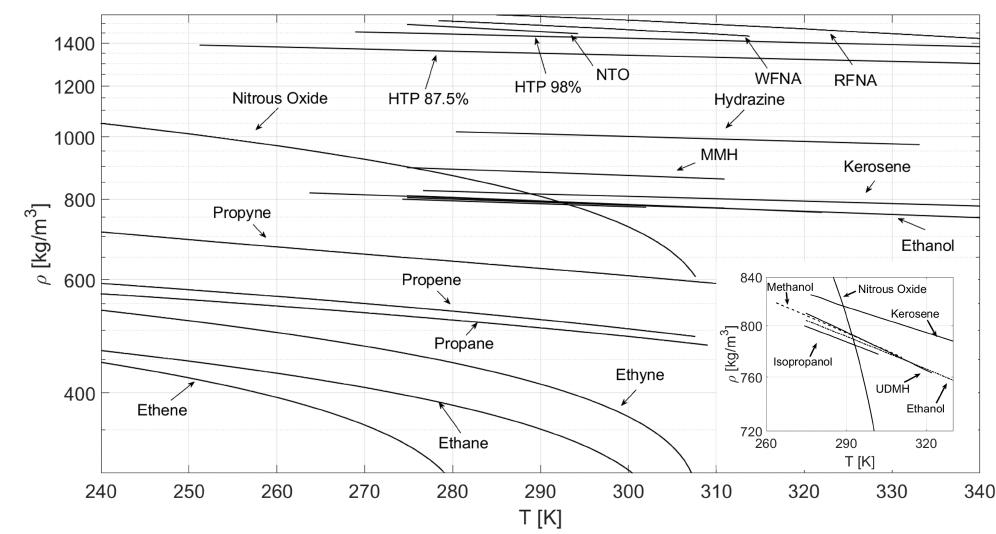
Figure 2. Oxidizers and fuels density